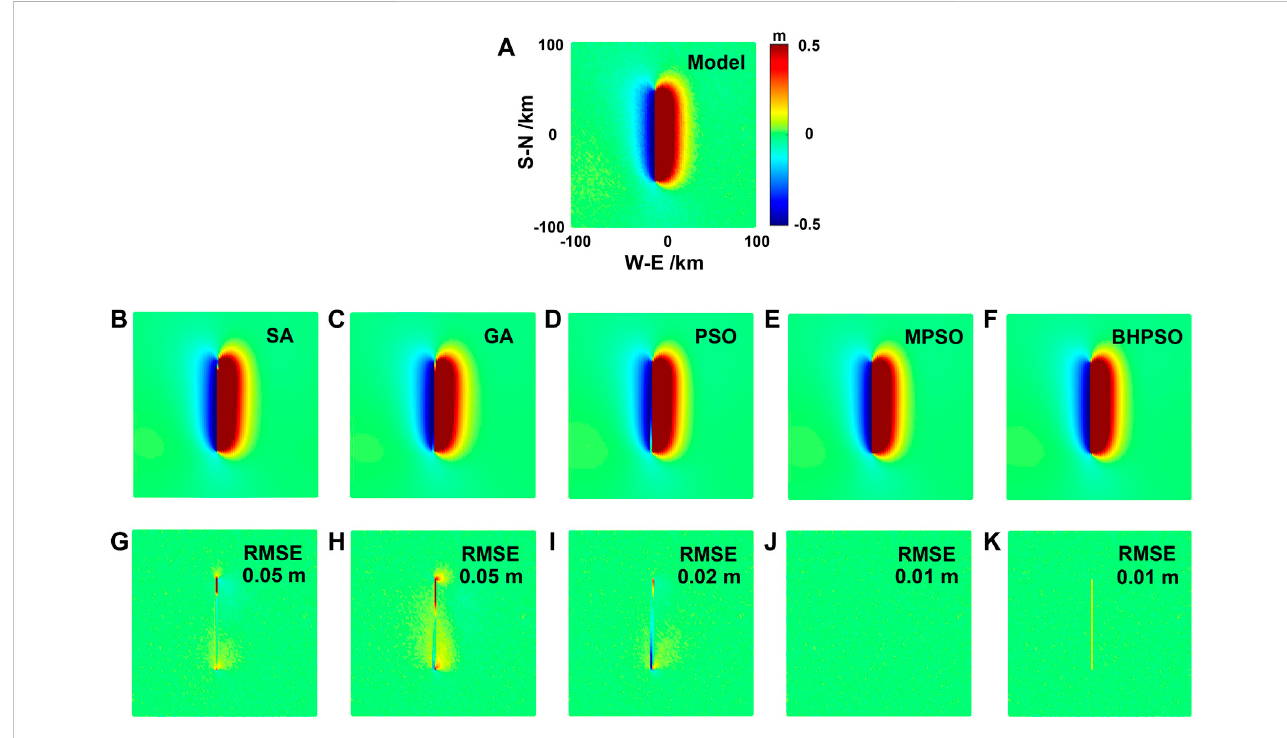
FIGURE 5 The comparisons of surface horizontal deformation (InSAR data) of the Okada model results from the pure dip-slip fault earthquake by using fault parameters given by the model and inversed from fi ve methods in Table 2. The surface horizontal deformation obtained by model (A) , SA method (B) , GA method (C) , PSO method (D) ,MPSO method (E) , andBHPSO method (F) . The residual ofsurfacehorizontaldeformation between the results ofmodel and SA method (G) , model and GAmethod (H) , model and PSO method (I) , model and MPSO method (J) , model and BHPSO method (K) . The bluearrowsshow the simulated surface horizontal deformation by the model in Table 2. The red arrows show the simulated surface horizontal deformation by using the fault parameters inversed from the fi ve methods. The black arrows show the fi tting residuals. The positive value in color bar is the deformation away from the satellite, while the negative value is the deformation close to the satellite.